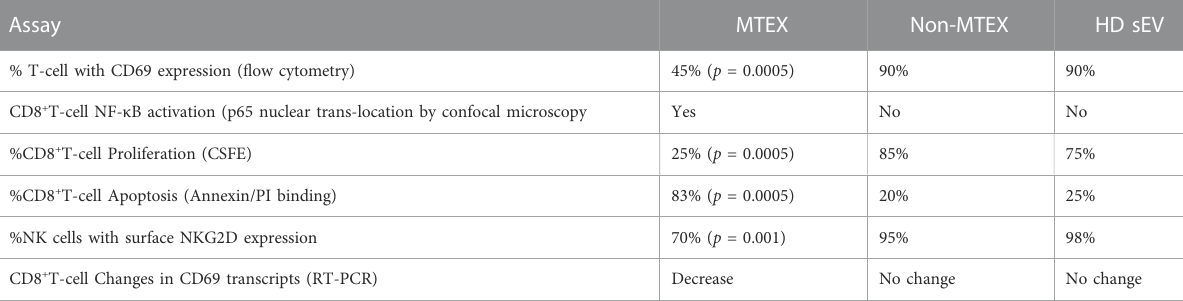
TABLE 3 Results of coincubation assays of the isolated vesicles with immune cells a .